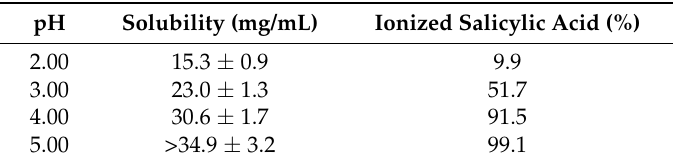
Table 1. Saturated solubility of salicylic acid in the aqueous phases at different pH values. In all cases n = 3 and the standard deviation is indicated by ± .